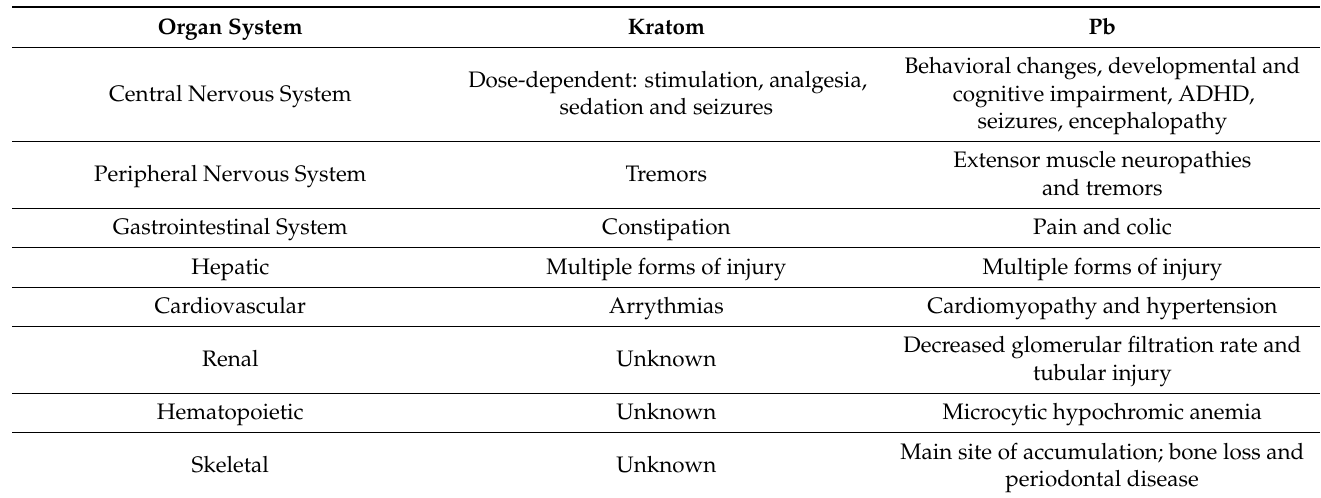
Table 1. A summary of the major pharmacologic/toxicologic effects of kratom and